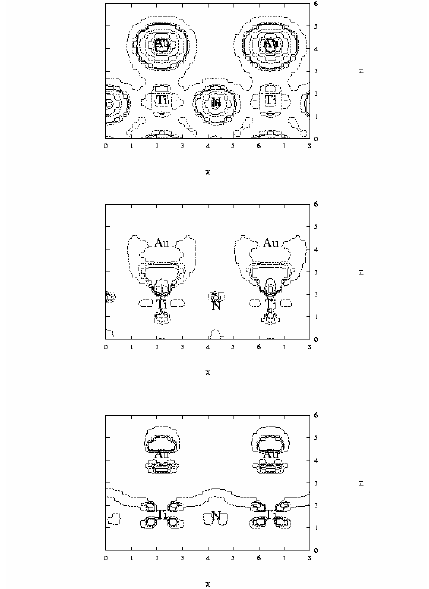
Figure 6. Electron density maps for Au adsorbed on-top of Ti surface atoms obtained from periodic GGA DFT calculations. Top: total density; levels: 100, 300, 400, 500, 1000, 1500, 2000. Difference between the total density and those of the fragments, i.e. (Au+TiN)-(Au)-(TiN), is reported at the mid- dle (positive) and at the bottom (negative). For density difference the positive levels are: 10, 30, 40, 50, 100, 150, 200, and the negative: –100, -50, -40, -30, and